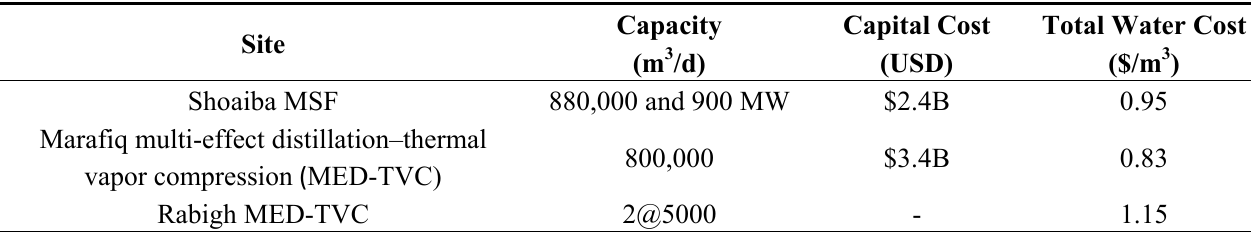
Table 1. Water cost of different thermal desalination projects in Kingdom of Saudi Arabia (KSA), including subsidies (Global Water Intelligence/Water Desalination Report (GWI/WDR),